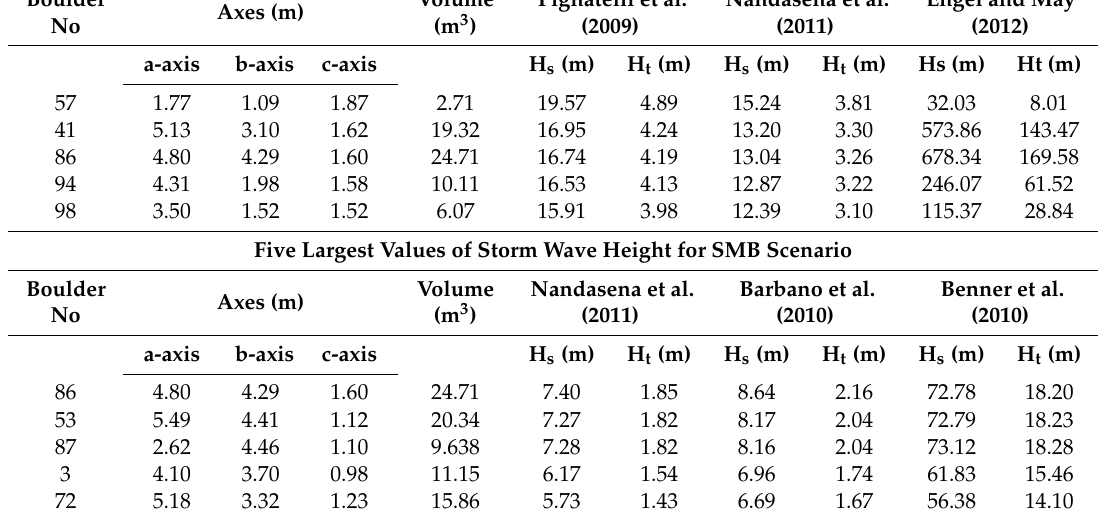
Table 3. Dating results of shell fragments collected on boulders.